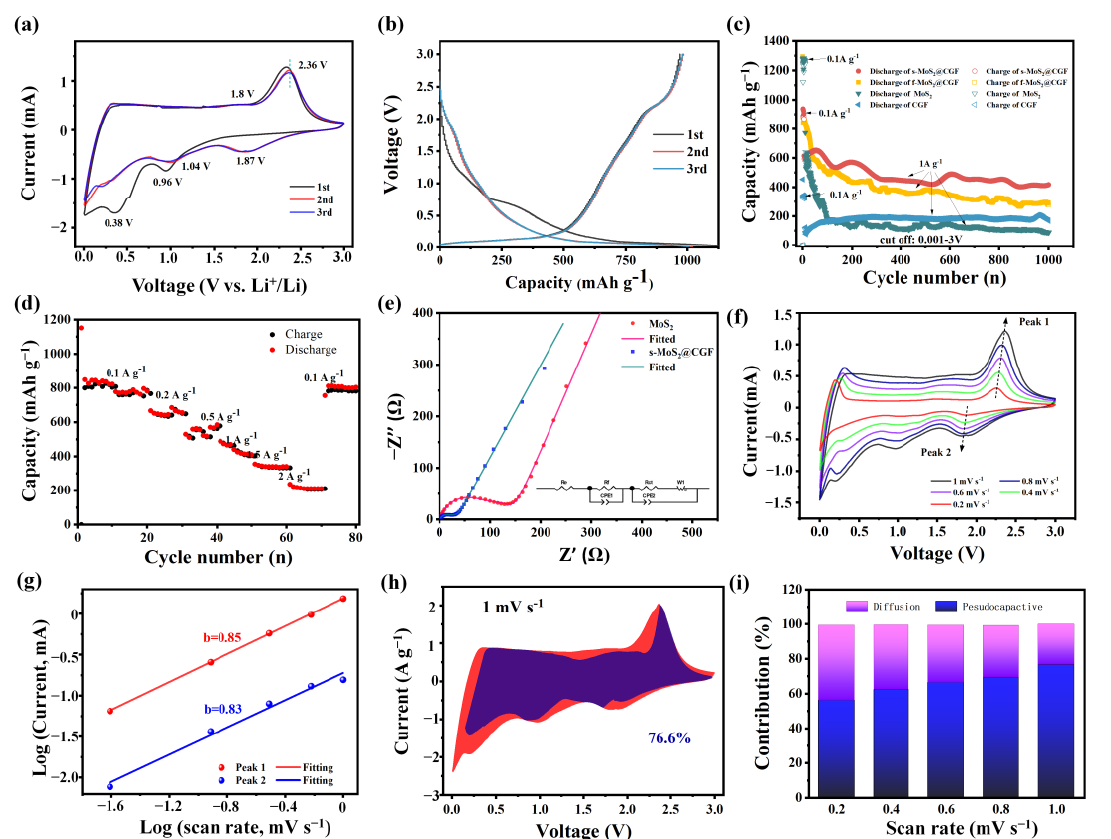
Figure 5. ( a ) CV curves of s-MoS 2 @CGF electrode in different cycles; ( b ) selected charge–discharge voltage profiles; ( c ) cycling performance; ( d ) rate capability; ( e ) EIS spectra e after 10 cycles recorded in the frequency range of 0.1–10 6 Hz; ( f ) CV curves of s-MoS 2 @CGF at different scan rates; ( g ) logarithm peak current versus logarithm scan rate at peak 1 and peak 2; ( h ) Voltammetric responses for s-MoS 2 @CGF at sweep rate of 1mV s −1 , the specific pseudocapacitive contribution is shown in purple region; ( i ) proportion of pseudocapacitive contribution at different scan rates.